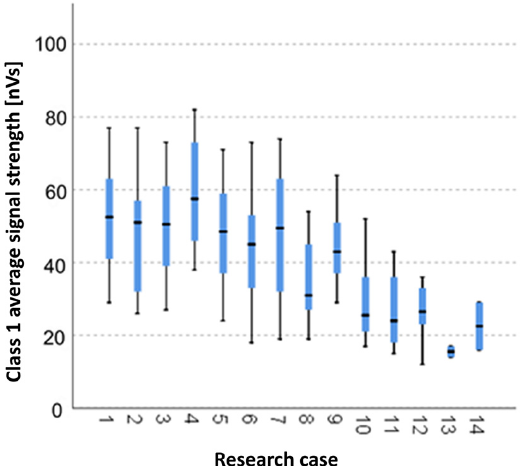
Figure 17. The graphical representation of the Kruskal-Wallis test results for independent samples of the average signal strength of the class 1 signals.